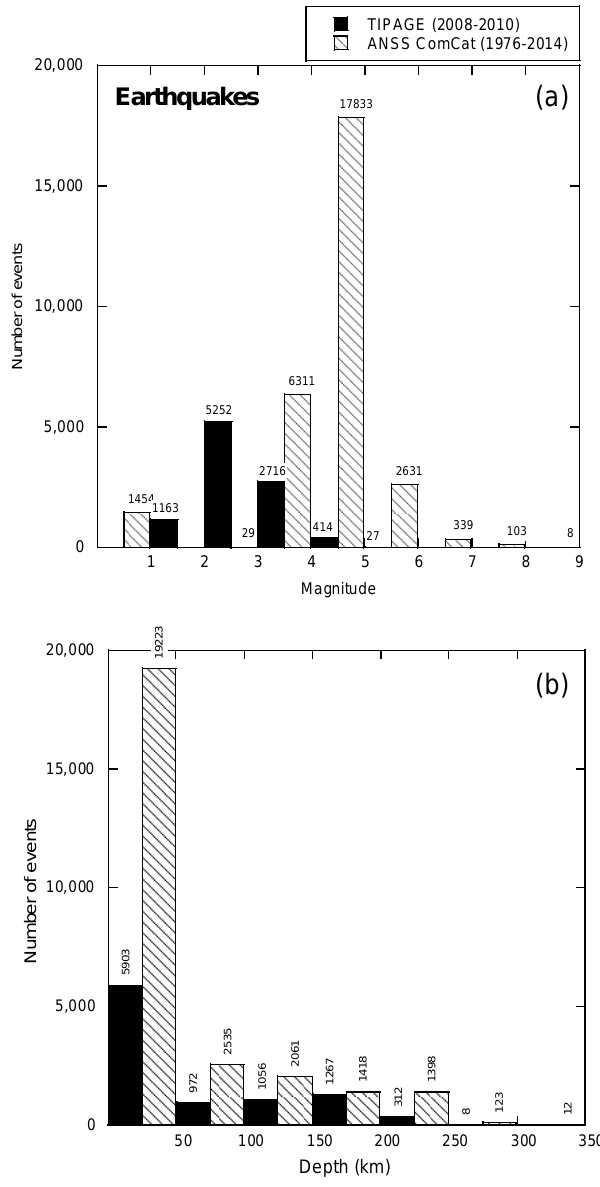
Figure 3. Earthquake distribution based on magnitudes (a) and depths (b) from global (ANSS ComCat) and regional (TIPAGE)